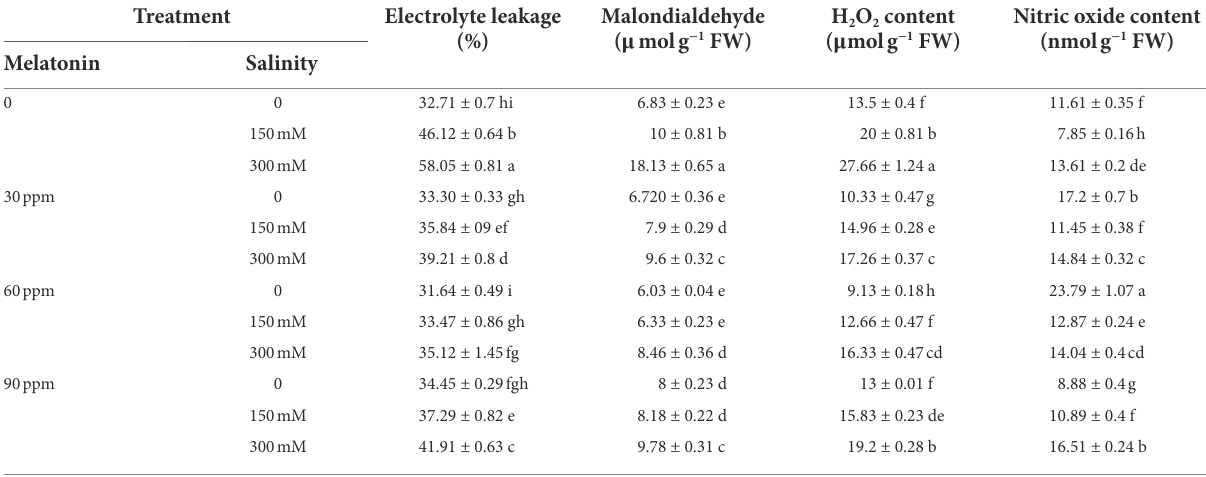
TABLE 3 The mean comparison effects of melatonin concentrations and different levels of NaCl on malondialdehyde content, electrolyte leakage index, H 2 O 2 , and nitric oxide